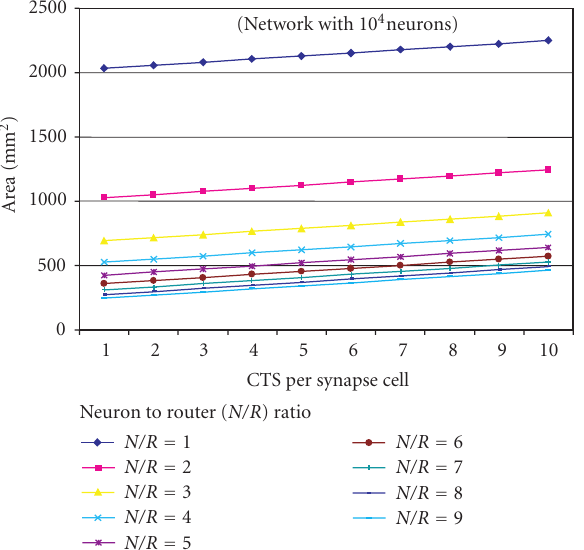
Figure 12: Optimisation: number of CTS per synapse cell .